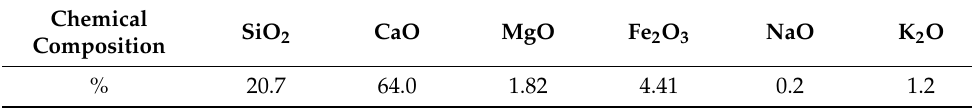
Table 1. Chemical composition of Portland cement.